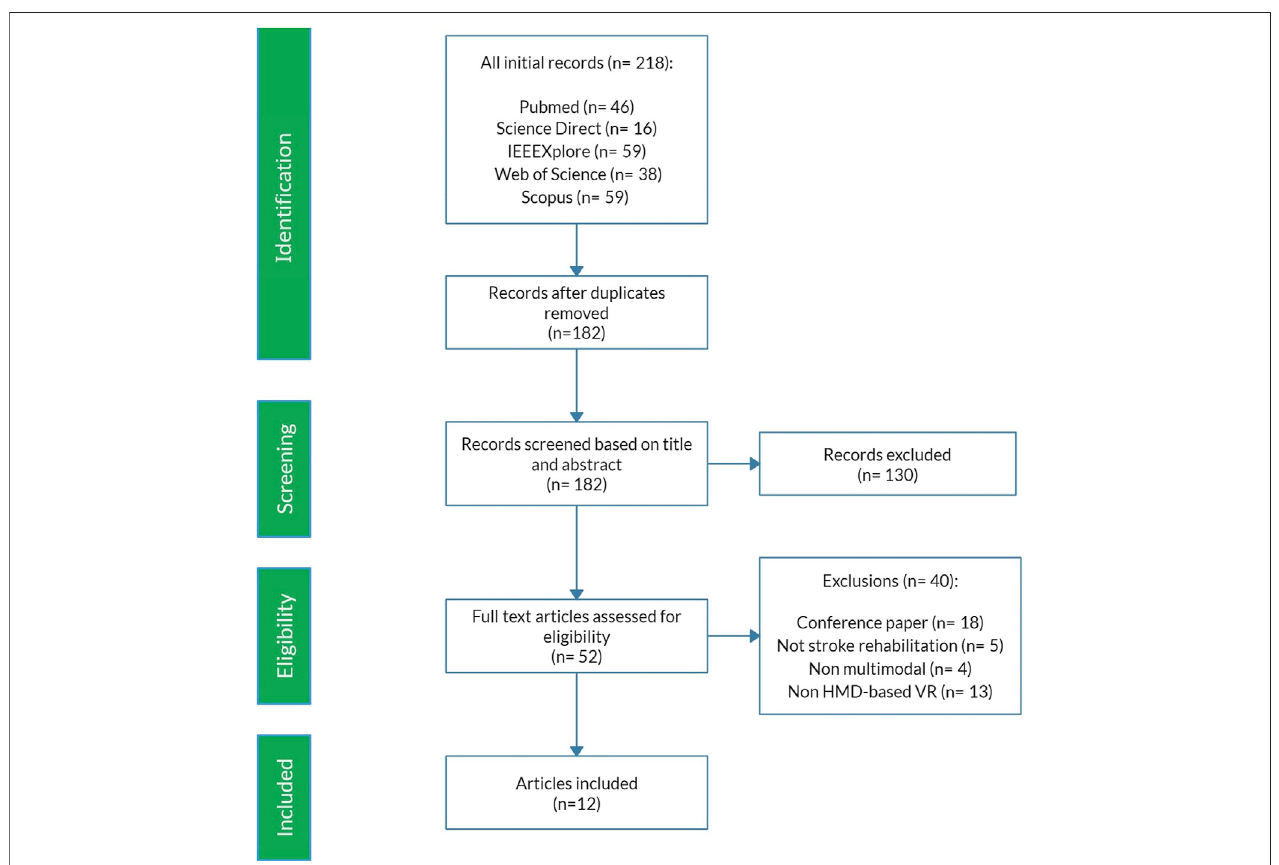
FIGURE 1 | Flow chart of paper selection